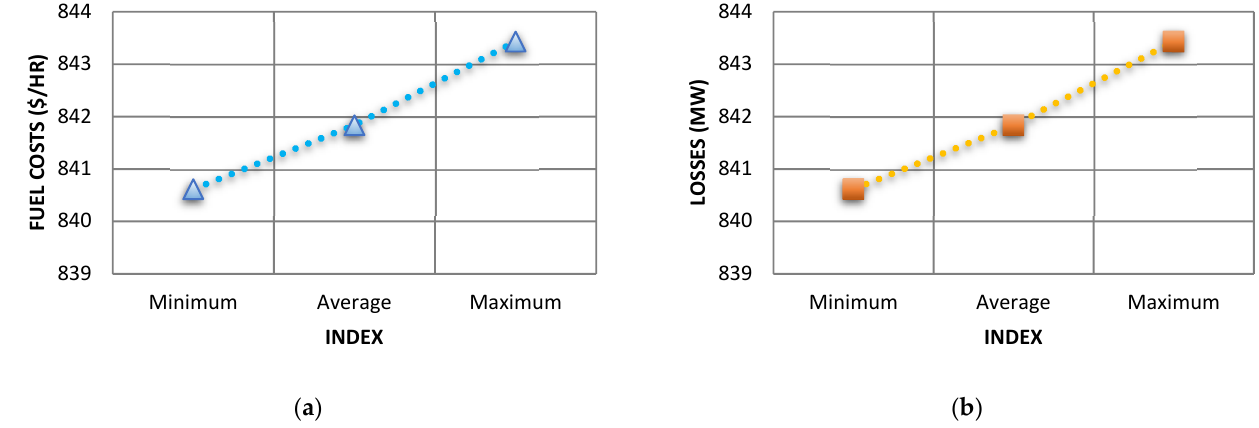
Figure 8. Statistical analysis curves of TLBA for the second system. ( a ) Instance 1; ( b ) Instance 2.